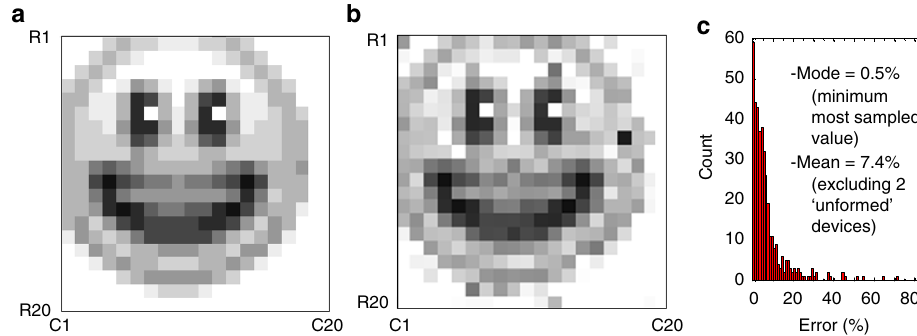
Fig. 3 High precision tuning. a The desired “ smiley face ” pattern, quantized to 10 gray levels. b The actual resistance values measured after tuning all devices in 20 × 20 memristive crossbar with the nominal 5% accuracy, using the automated tuning algorithm 48 , and c the corresponding statistics of the tuning errors, which is de fi ned as normalized absolute difference between the target and actual conductance values. On panel a , the white/black pixels correspond to 96.6 K Ω /7 K Ω , measured at 0.2 V bias. The tuning was performed with 500- µ s-long voltage pulses with amplitudes in a [0.8 V, 1.5 V]/ [ − 1.8 V, − 0.8 V] range to increase/decrease device conductance. (Supplementary Fig. 3 shows absolute values of resistances and absolute error for the data on panels b and c ,